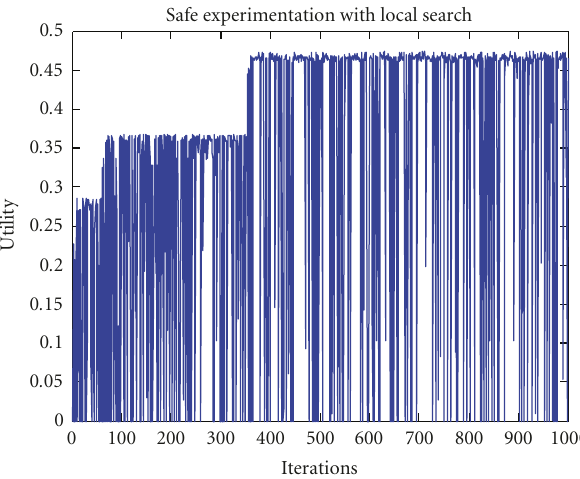
Figure 8: Convergence of safe